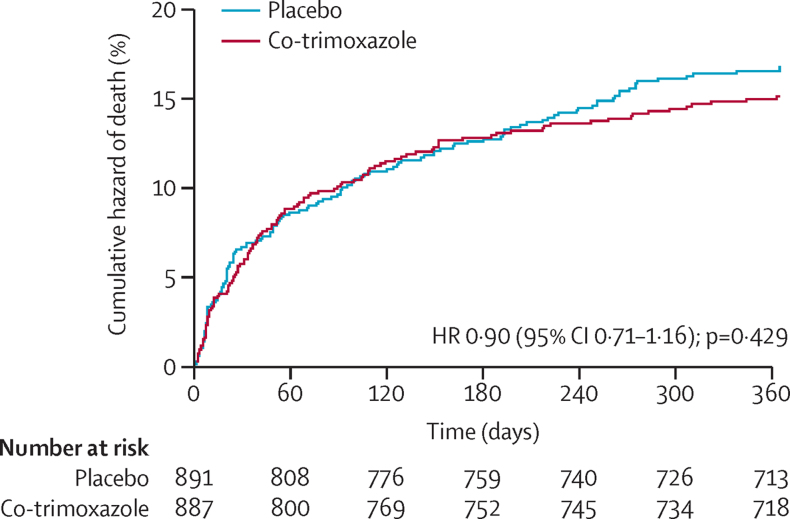
Cumulative hazard curves for time to deathKaplan-Meier curves are shown for time to death until 365 days. The time at risk observed was 763·3 and 763·3 child-years in the co-trimoxazole group and placebo group, respectively, of which 395·3 and 398·7 child-years, respectively, were during the first 6 months while receiving the study drug. HR=hazard ratio.